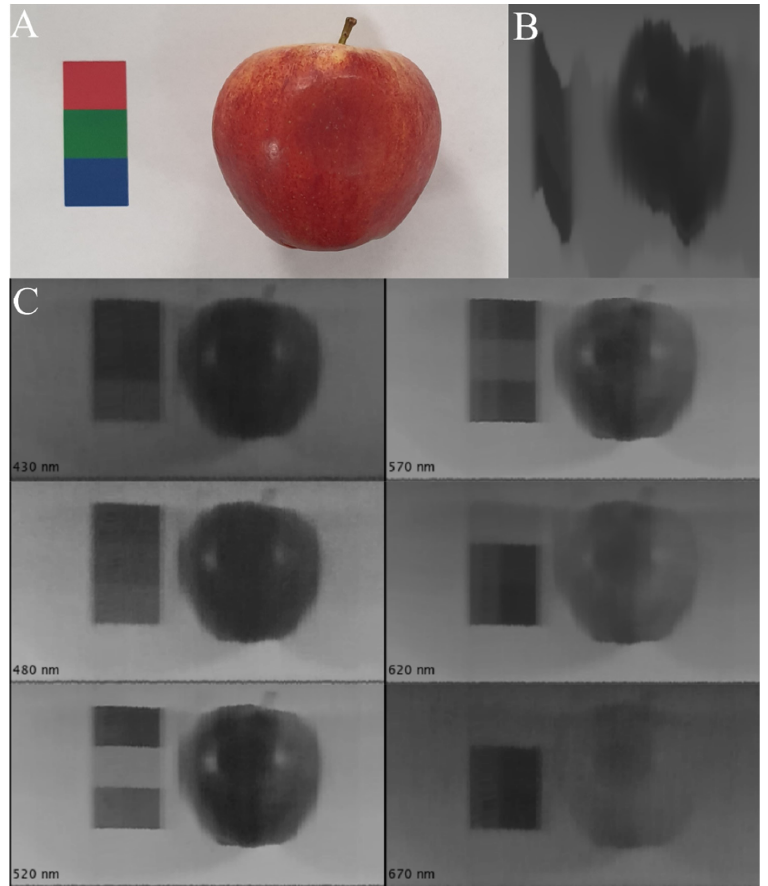
Figure 11. ( A ) A photograph of the measurand apple. ( B ) A raw frame from the data cube. ( C ) Six spectral bands of a hyperspectral image of a red Gala apple demonstrating the varying levels of detection across the wavelength range of the instrument.